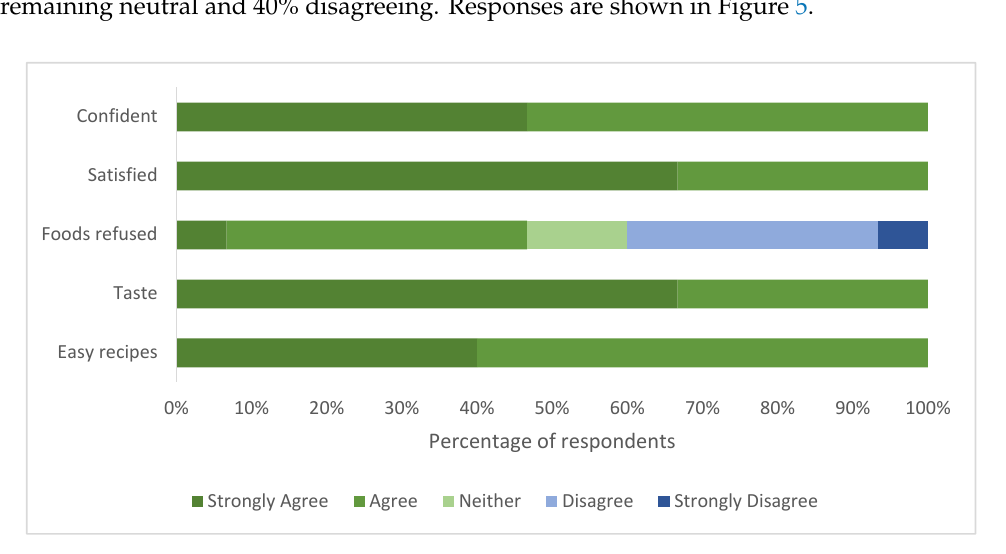
Figure 6. Intervention participant ( n = 15) opinions on the length, frequency, scheduling and benefit of the text message support component of the AusMed diet program. 4. Discussion These results provide preliminary trial evidence of the feasibility of a Mediterranean diet program designed to be specific to an older Australian population. In the Phase 1 process evaluation,